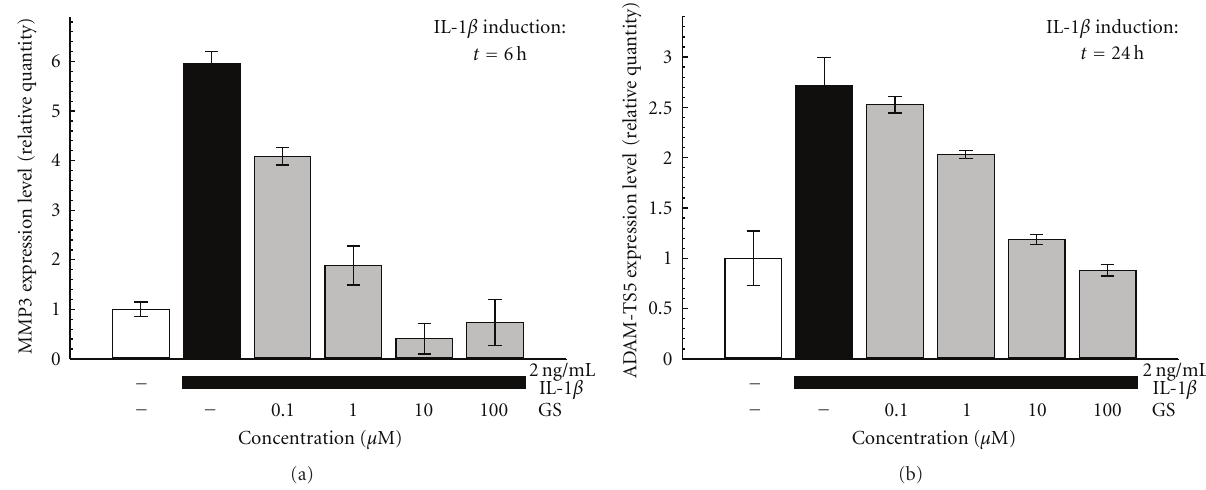
Figure 2: E ff ect of GS on IL-1 β -induced gene expression of MMP-3 (a) and ADAM-TS5 (b). One hour after the pretreatment with GS (0,1– 100 μ M), SW1353 are stimulated with IL-1 β (2ng/mL) as indicated. Representative pictures of 3 to 5 independent experiments are shown. Data are mean ± SD of three